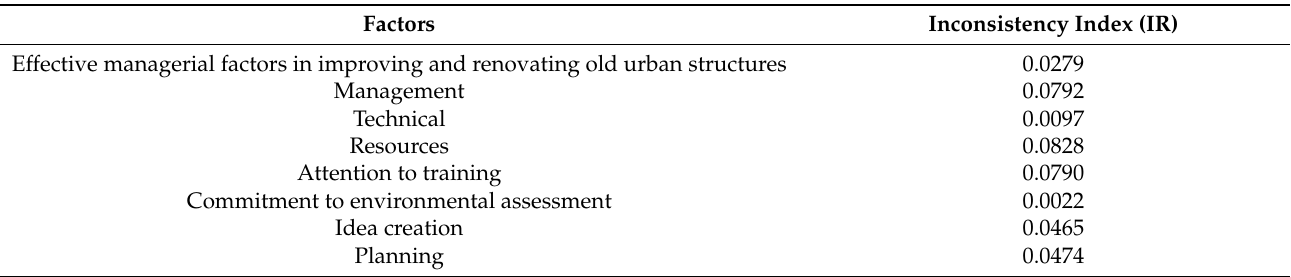
Table 28. The factors’ inconsistency